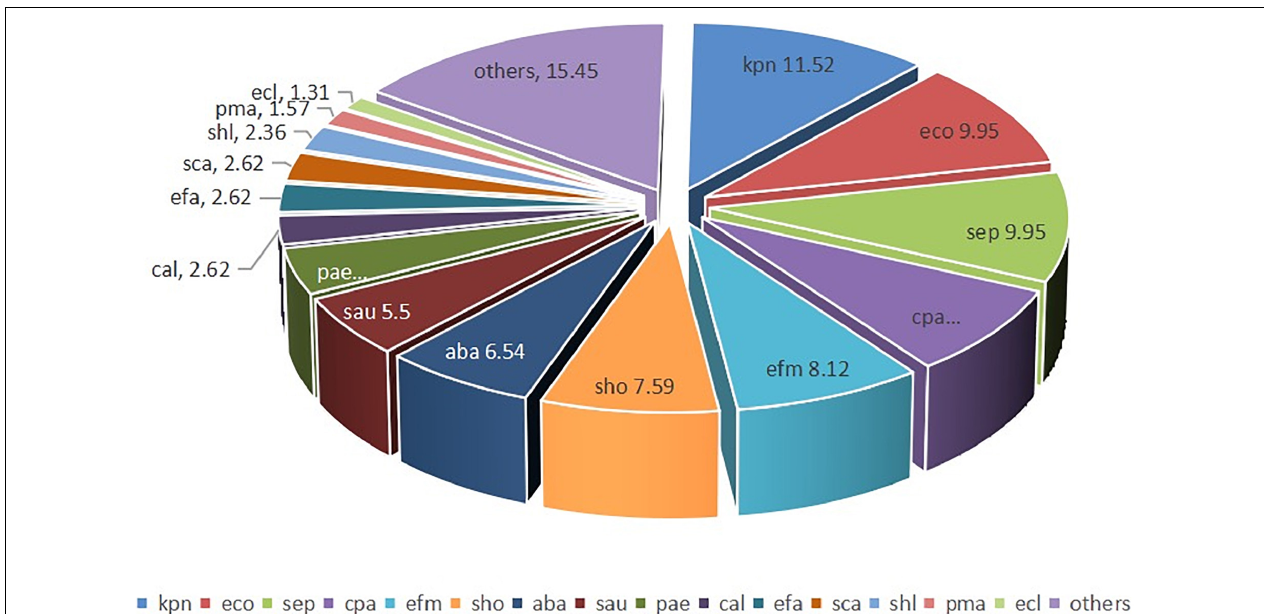
FIGURE 4 | Distribution of the isolated pathogens in blood culture samples (%). kpn, K. pneumonia ; eco, E. coli ; sep, S. epidermidis ; cpa, C. parapsilosis ; efm, E. faecium ; sho, S. hominis ; aba, A. baumannii ; sau, S. aureus ; pae, P. aeruginosa ; cal, C. albicans ; efa, E. faecalis ; sca, S. capitis ; shl, S. haemolyticus ; pma, Stenotrophomonas maltophilia ; and ecl, E.